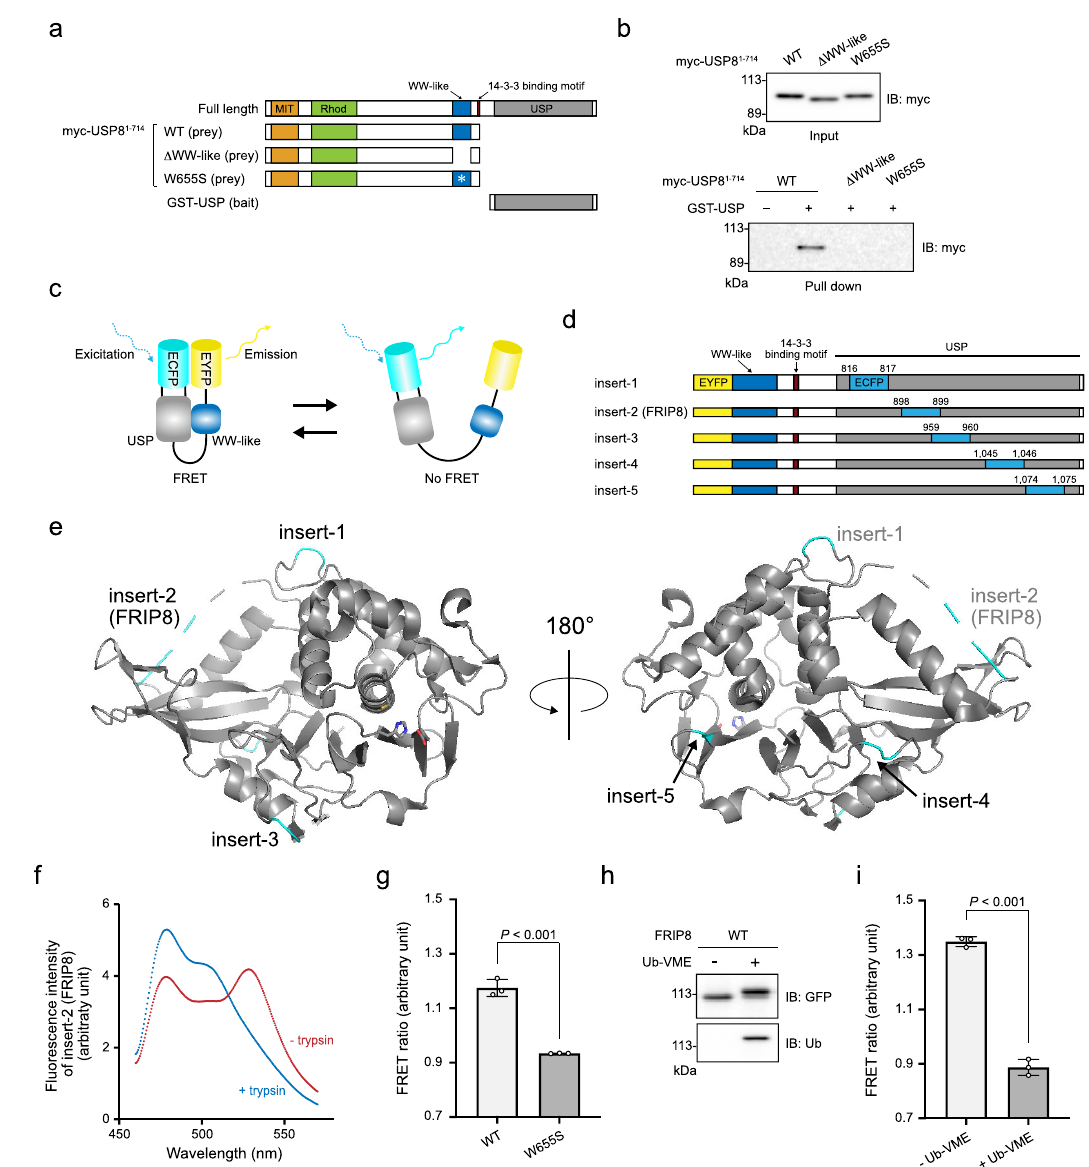
Fig. 3 Interaction between the WW-like and USP domains. a Schematic structures of the prey and bait proteins used in b . b Pull-down assay. Lysates of HEK293T cells expressing myc-tagged USP8 1 – 714 (WT or mutants) were incubated with GST-tagged USP domain, subsequently precipitated using glutathione beads. The adsorbed fraction and input were analysed using immunoblotting. c Schematic representation of single-molecule FRET probes used to detect the interaction. d Schematic structures of the probes. e ECFP insertion points are depicted on a crystal structure of the USP domain (PDB ID: 2GFO). Two representations are rotated by 180° around the Y-axis. f Emission spectra of FRIP8 at an excitation wavelength of 433 nm. Lysate of HEK293T cells expressing FRIP8 was subjected to fl uorescence measurement with (blue) and without (red) trypsinisation. g FRET ratio of FRIP8 W655S . The emission spectra of FRIP8 W655S were measured by similar methods to those described in f . The ratio of the emission intensity of EYFP to that of ECFP (i.e. the FRET ratio) was calculated. The graph shows the means ± standard deviations of three independent experiments. Statistical signi fi cance was determined using Student ’ s t -test. h , i Ub-VME-labelling of FRIP8. Puri fi ed His-tagged FRIP8 was labelled with Ub-VME. It was subjected to immunoblotting ( h ) and a FRET assay ( i ). The graph shows the means± standard deviations of three independent experiments. Statistical signi fi cance was determined using Student ’ s t -test. See Supplementary Fig.